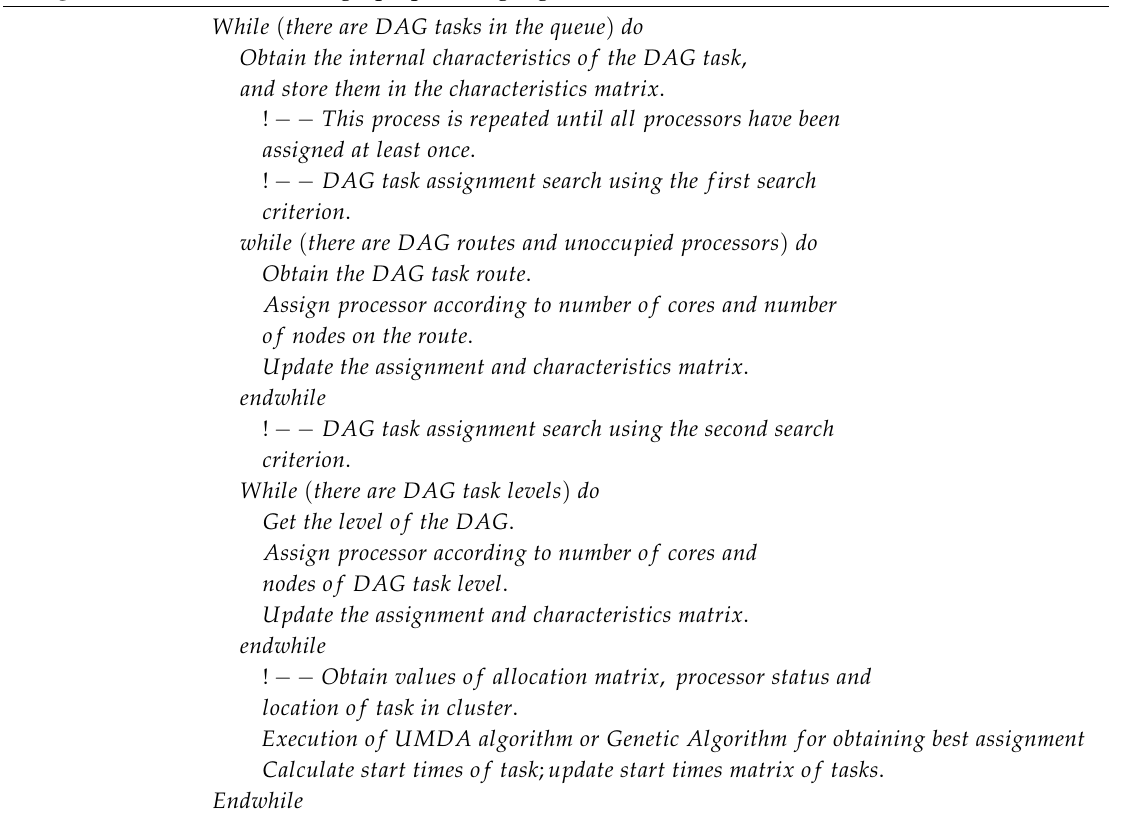
Algorithm A2: Parallel task graph planning